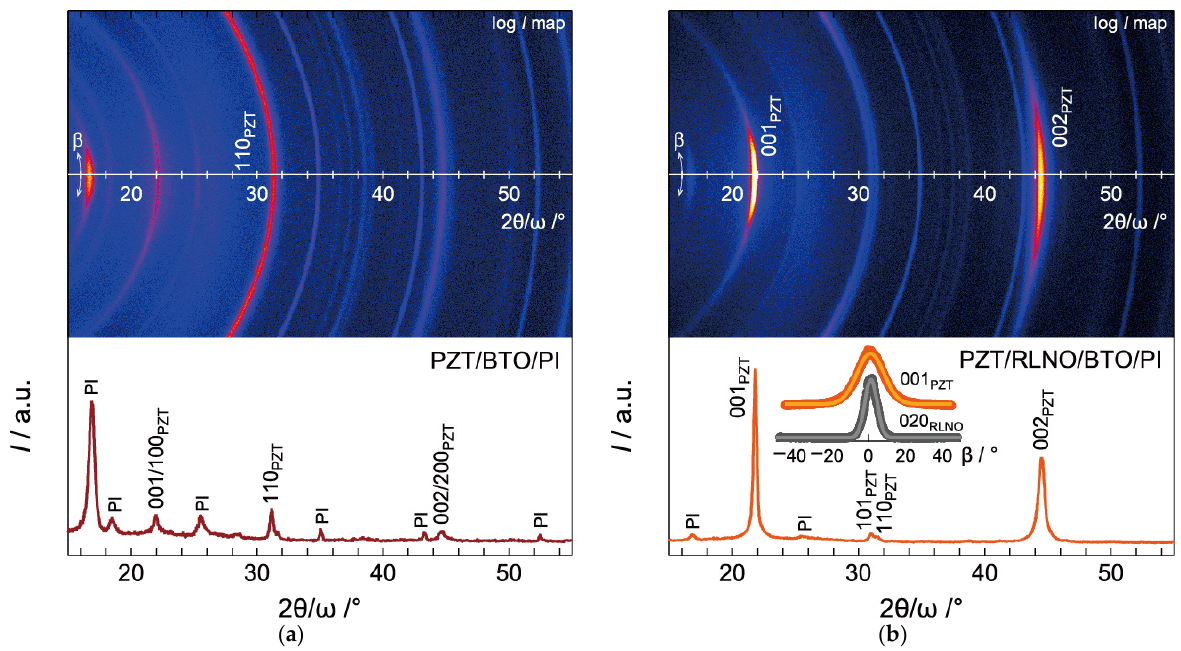
Figure 5. ( a ) Numerically simulated temperature maps across depth ( d ) and time ( t ) for the amor- phous precursor RLNO thin film on a BTO/PI substrate irradiated at a KrF laser fluence of 35–55 mJ·cm − 2 . ( b ) Time dependence at the interface between RLNO and BTO ( d = 120 nm) and depth dependence ( t = 90 ns) of simulated temperature for the RLNO/BTO layers irradiated at a KrF laser fluence of 35–55 mJ·cm − 2 .